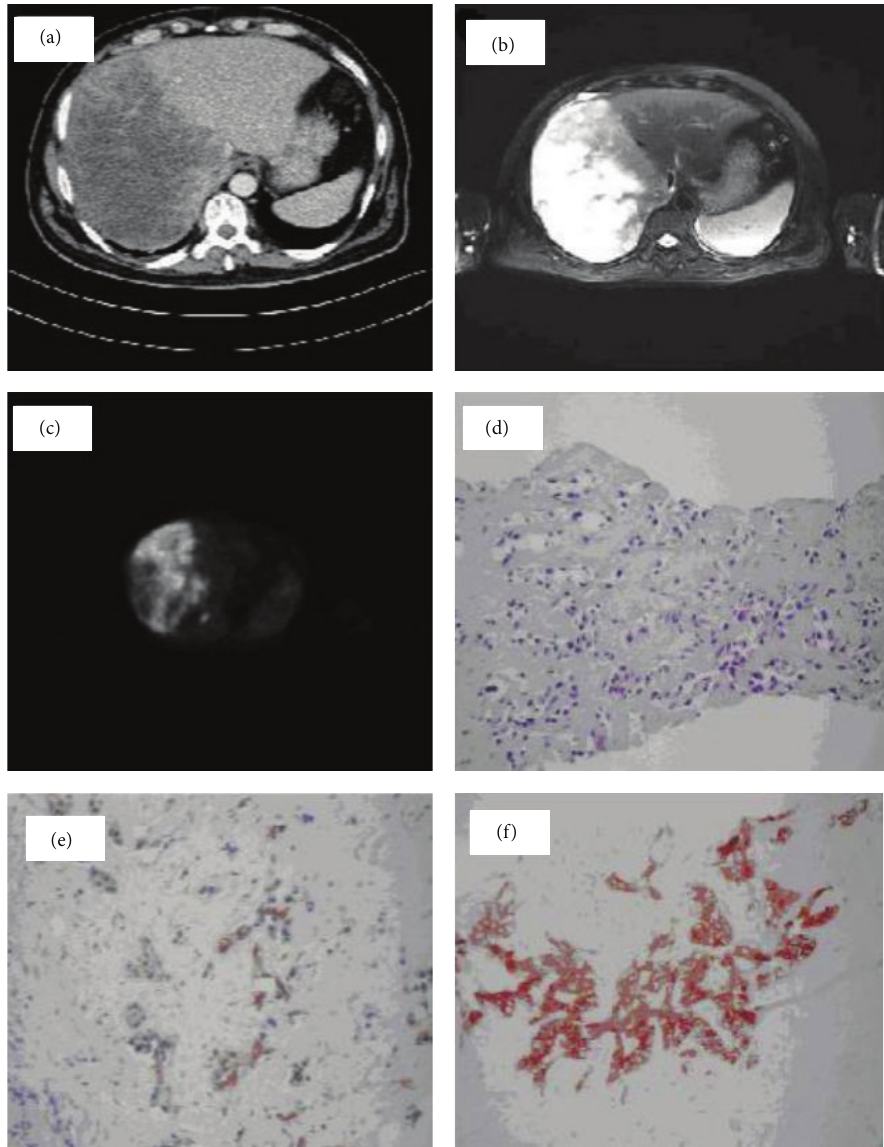
Figure 1: (a) CT scan, 20×14 cm size hypoattenuating multinodular tumor mainly filling the right lobe of the liver with irregular boundaries. (b) MR, T2-weighted images as a slightly hyperintense area with contrast enhancement of peripheral zone being liable to confluent multiple lesions in the right lobe of liver. (c) Fluorodeoxyglucose-positron emission tomography (FDG-PET) showed 10.7 of a standardized uptake value for FDG in CC of liver. (d) Tumor cells diffusely formed ductal structures in fibrotic stroma and have a big hyperchromatic nucleus in narrow cytoplasm, H&E, × 200. (e) Tumor cells diffusely replaced the liver parenchyma and formed ductal structures in fibrotic stroma which were positively stained for cytokeratin 19 immunoreaction, × 200. (f) Tumor cells diffusely replaced the liver parenchyma and formed ductal structures in fibrotic stroma which were positively stained for cytokeratin 7 immunoreaction ×